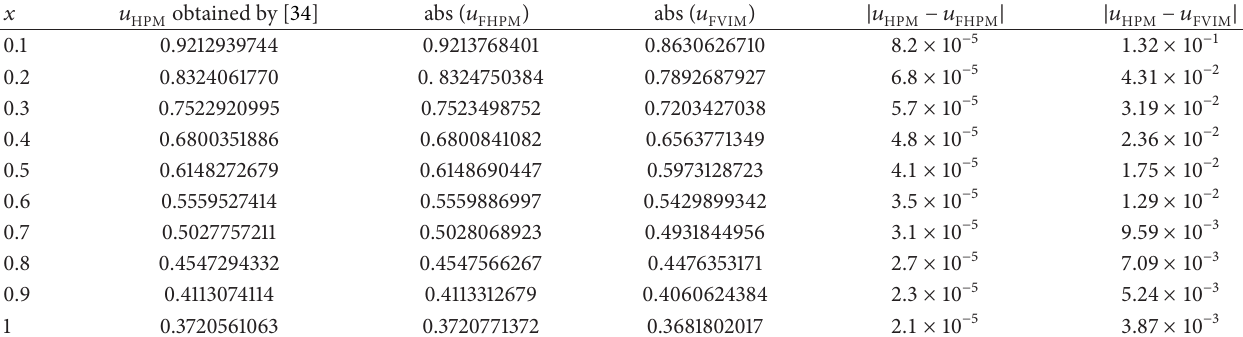
Table 1: This table shows the absolute error between the approximate solutions (32), (38) and the approximate solution in [34] when 𝑡 = 0.01 and 0 < 𝑥 < 1 .